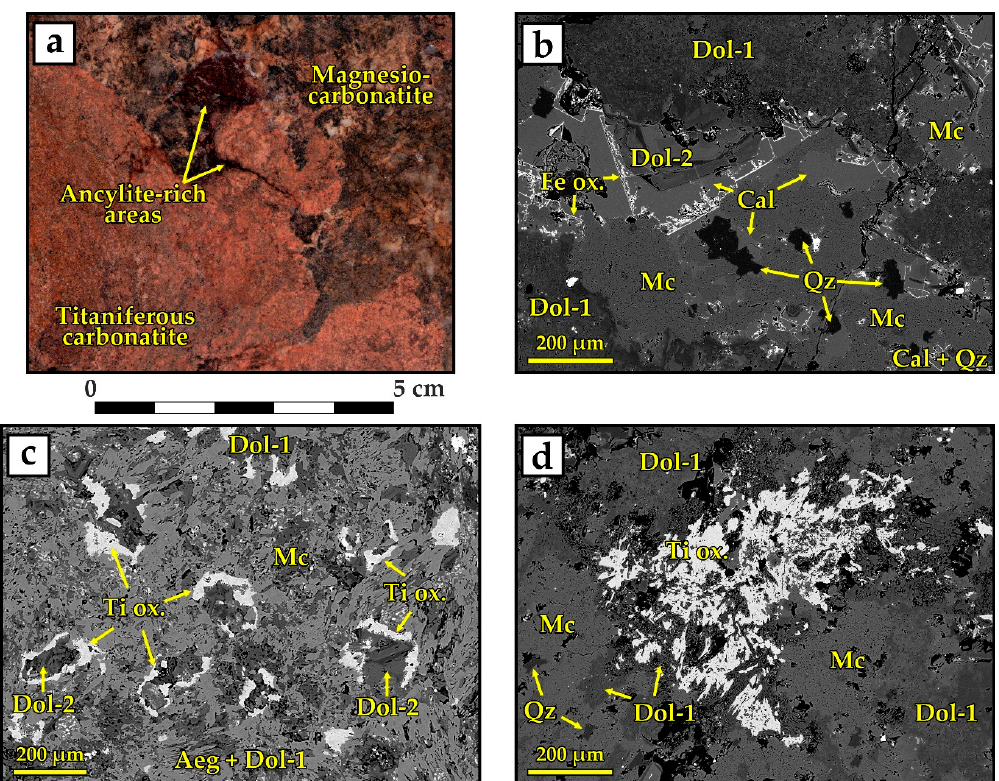
Figure 4. High-Ti carbonatite. ( a ) Polished sample from the contact of high-Ti carbonatite and least altered magnesiocarbonatite. The dark red area contains abundant ancylite. ( b ) A mineralized crack filled with late calcite, quartz, and zoned Dol-2 in the groundmass of the microcline and spongy dolomite Dol-1. ( c ) Fragment of zoned Dol-2, isolated from spongy Dol-1, aegirine, and the microcline by the rims of titanium oxides. ( d ) Titanium oxides, intergrown with dolomite and microcline. Photomicrographs ( b – d ) were imaged in backscattered electron (BSE) mode. Dolomite in these rocks is represented by two generations. The earliest generation (Dol-1), comprising the bulk of high-Ti carbonatites, is turbid, spongy, and xenomorphic (Figure 4b). This generation is chemically heterogeneous due to variability in its Mg/Fe ratio (19 ± 8 mol. % Ank ). Its manganese content is low (3 ± 4 mol. % Kut ). The spongy dolomite is chemically similar to dolomite Dol-1 from the unaltered magnesiocarbonatites (Fe-rich, without Sr). Dol-1 from high-Ti carbonatites hosts abundant inclusions of Fe oxides and hydroxides (mostly goethite and hematite). The late generation dolomite Dol-2 is adjacent to the selvages of mineralized fractures. Dol-2 differs from Dol- 1 in its compact morphology, optical clarity, idiomorphic appearance, and fine oscillatory zoning (Figure 4b). Compared with Dol-1, Dol-2 contains significantly less Mg and Mn, and its content is much less variable (4 ± 3 mol. % Ank , 3 ± 2 mol. % Kut , without Sr). Dol-2 occurs sporadically in the groundmass composed of Dol-1. There, Dol-2 occurs as grains isolated from spongy Dol-1 by rims of titanium oxides (Figure 4c).